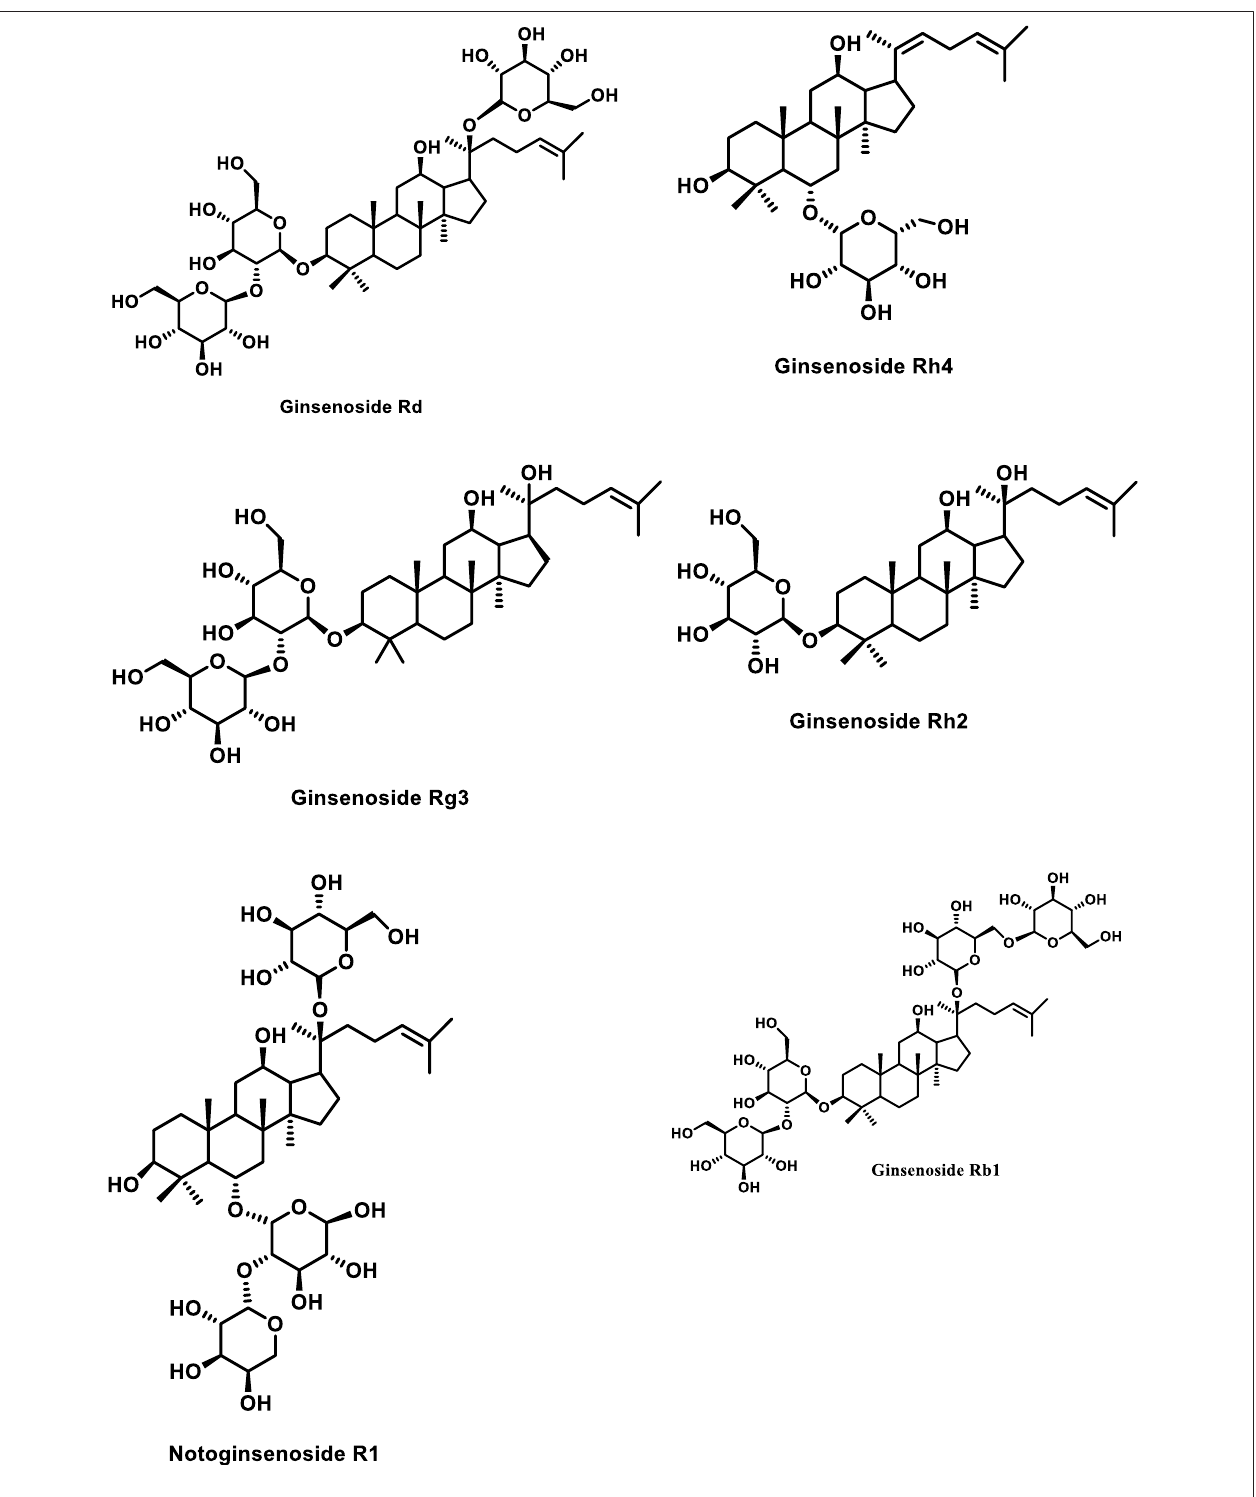
FIGURE 1 | Structures of representative ginseng saponins. PPD, protopanaxadiol; PPT, protopanaxatriol.